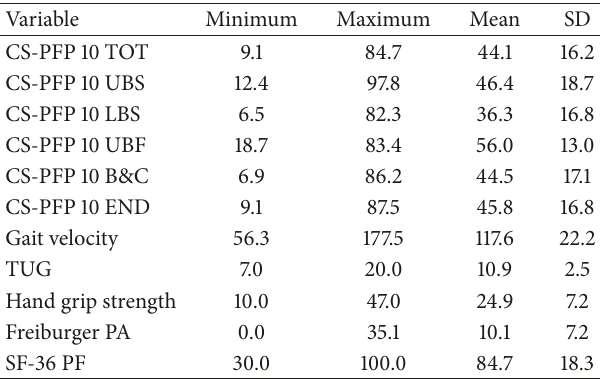
Table 3: Descriptive data of the